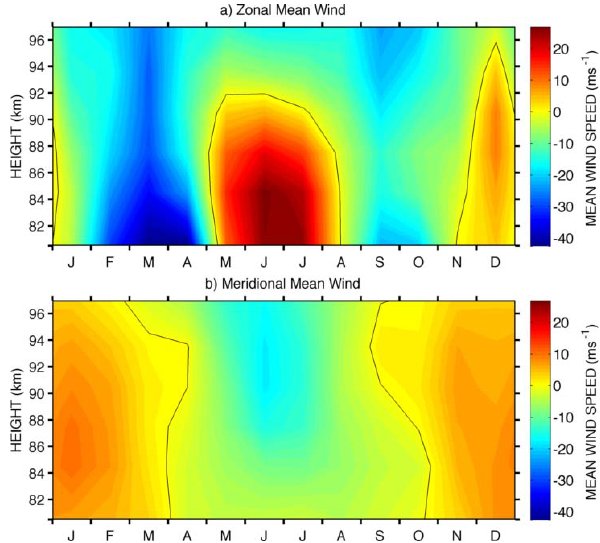
Fig. 4. Composite-year monthly-mean winds over Ascension Is- land for the (a) zonal and (b) meridional components for all data recorded from January 2002 to June 2011. The black line represents the zero-wind line.